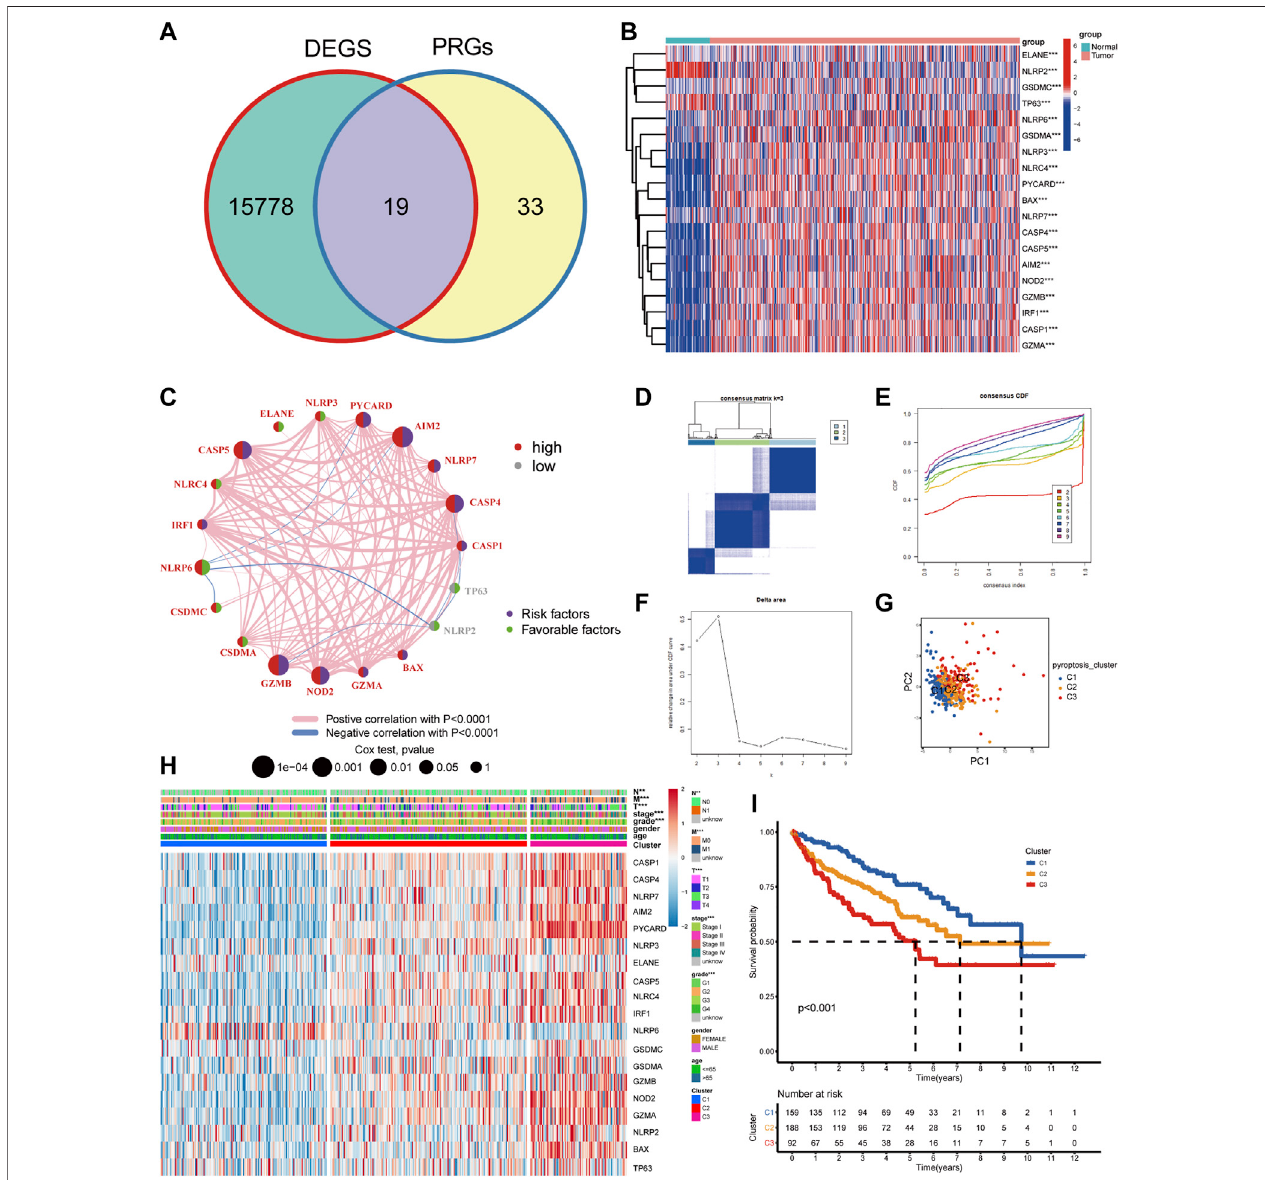
FIGURE 1 | The landscape ofDEPRGs in ccRCC and identi fi cation ofpyroptosis subtypes. (A) The Venn diagram showed overlapping genes. (B) A heatmap was used to show the differential expression of 19 DEPRGs expressions in ccRCC and noncancerous tissues. (C) Interaction between DEPRGs in ccRCC. The line connecting DEPRGs represented their interaction, and the strength of the correlation between DEPRGs was indicated by the thickness of the line. Pink and blue, respectively, represented positive and negative correlations. The color of the left half circle represented the gene expression in ccRCC, with high expression in